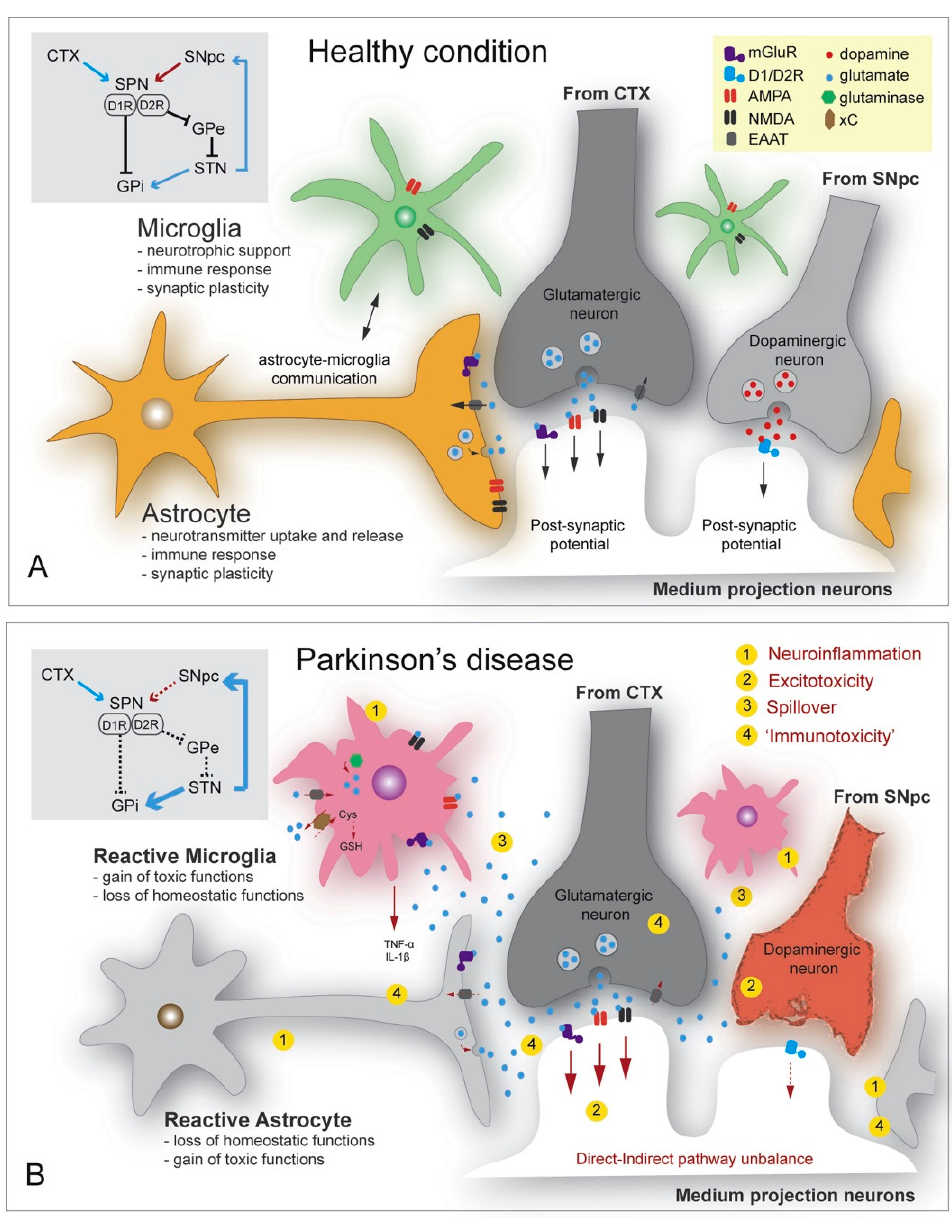
Figure 5. Glutamate and dopamine-related striatal events—focus on astrocytes and microglia functions in ( A ) healthy state, ( B ) Parkinson’s disease (PD) condition. Grey box: fronto-basal circuits involved in the modulation of voluntary movements and impaired connectivity caused by dopamine degeneration in PD. Reprinted from an open-access source [15]. Abbreviations: AMPA—al- pha-amino-3-hydroxy-5-methyl-4-isoxazolepropionic acid; CTX—cerebral cortex; Cys—cysteine;